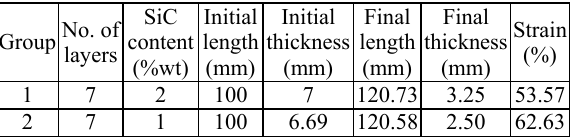
Figure 3. Designed and fabricated horn